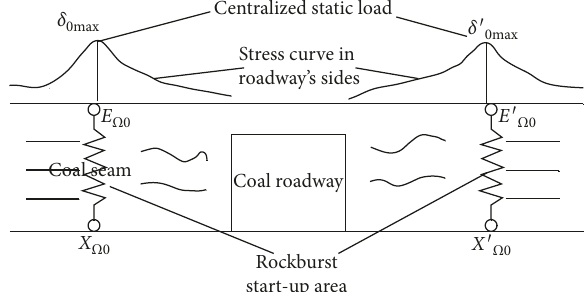
Figure 2: Engineering structure model of concentrated static load- type